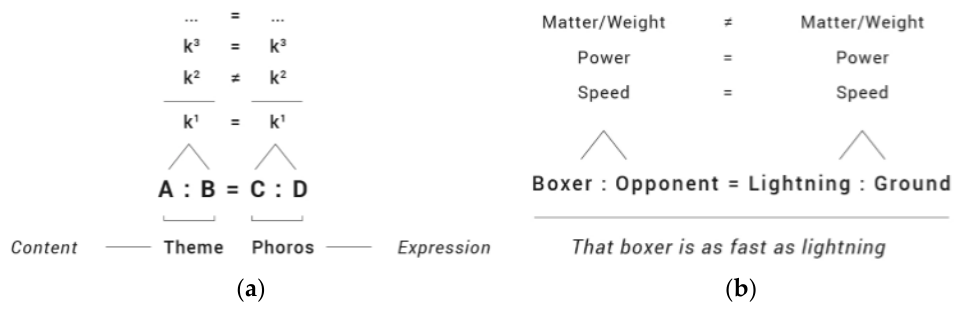
Figure 3. Model of the analogy: ( a ) Graphic visualization of the model’s structure. A phoros may be considered, when designing, the expression through which a content —or a theme —comes into being. The k-interpretant exists within both pairs’ relationships and, although just one will light up and interpret the analogy, it is shown how there would instead be a more complex set of them: either shared or not; ( b ) Example of a verbal analogy according to the reviewed model